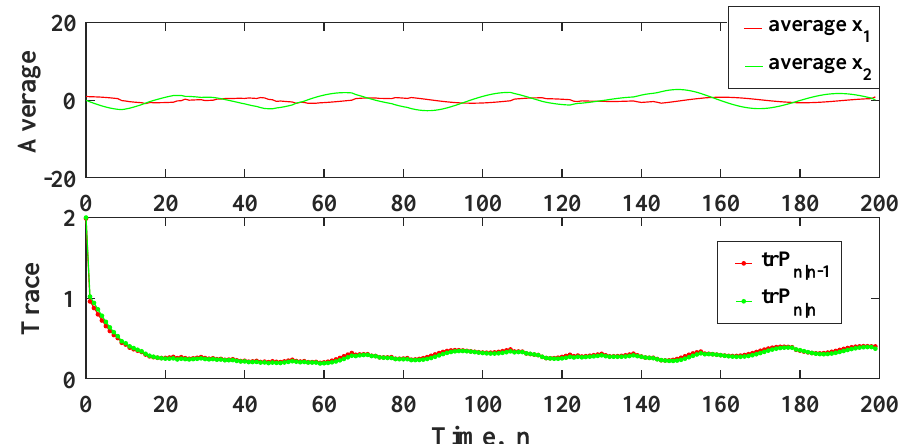
Figure 3. The boundedness of the estimation error and covariance